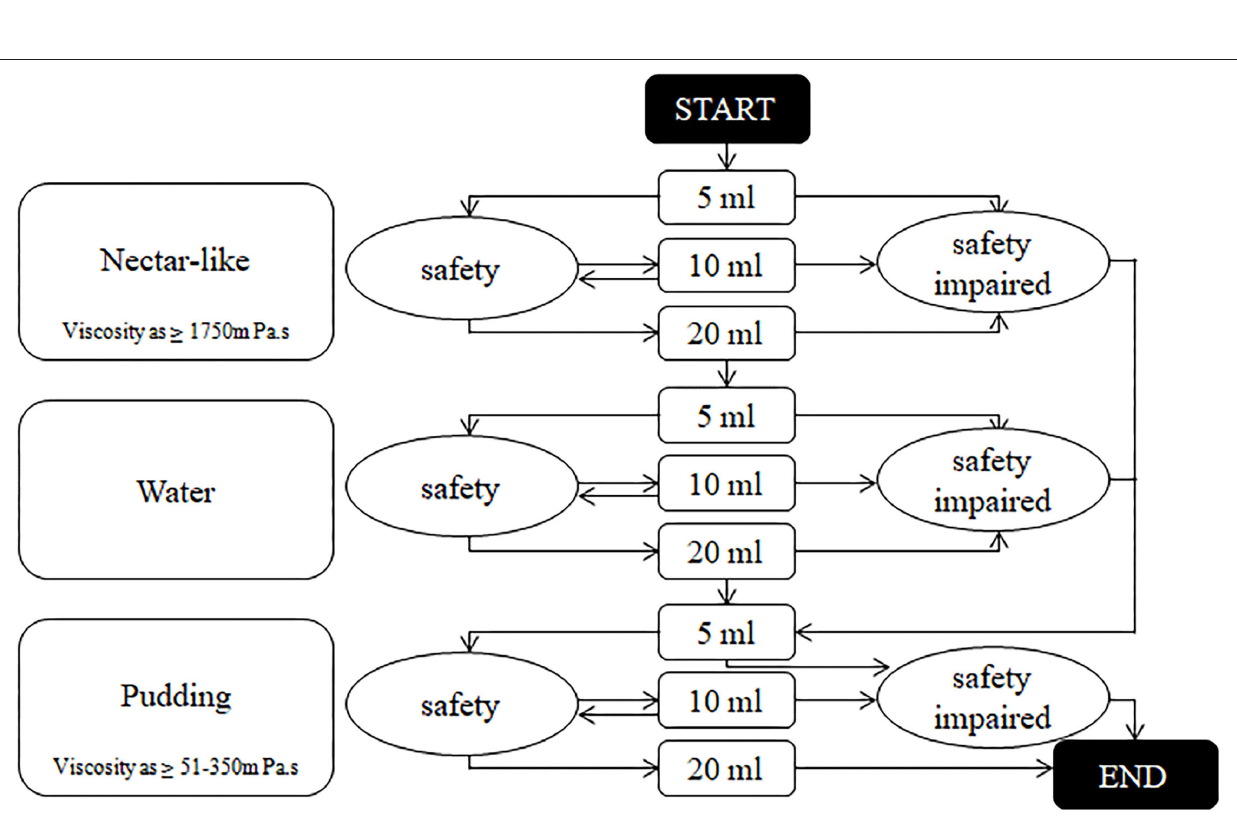
Frontiers in Nutrition |